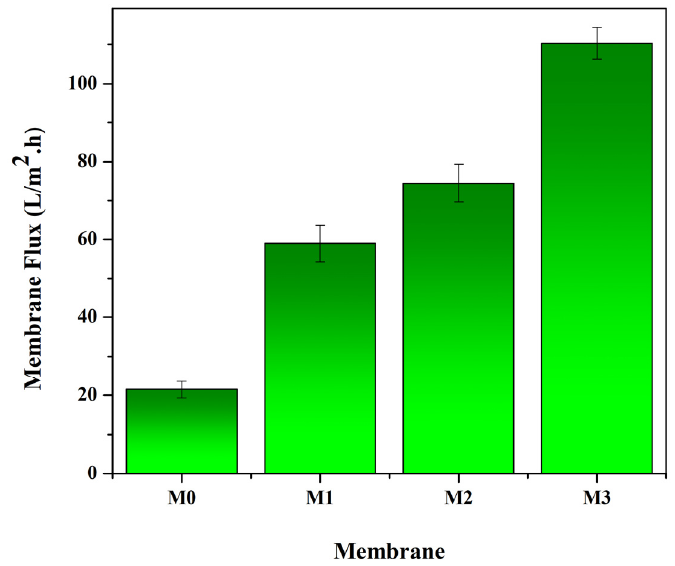
Figure 7. Water flux of the pure and modified PVDF membranes. The filtration test was designed as a crossflow filtration module with an operating pressure of 1 bar, and the permeate volume was collected every 10 min. Water flux was calculated using Equation (4).